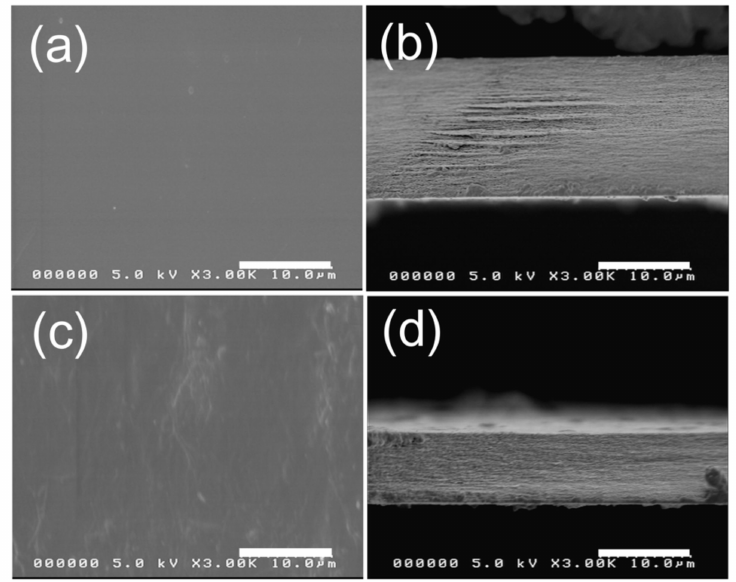
Figure 4. FE-SEM images of: ( a ) surface of CNF film; ( b ) cross section of CNF film; ( c ) surface of ChNF–CNF composite; and ( d ) cross section of ChNF–CNF composite.